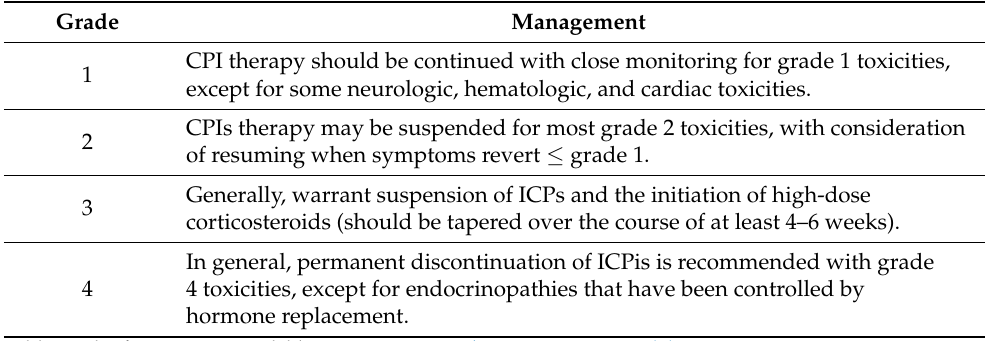
Table 4. Summary of ASCO recommendations on irAEs management in patients treated with CPIs.